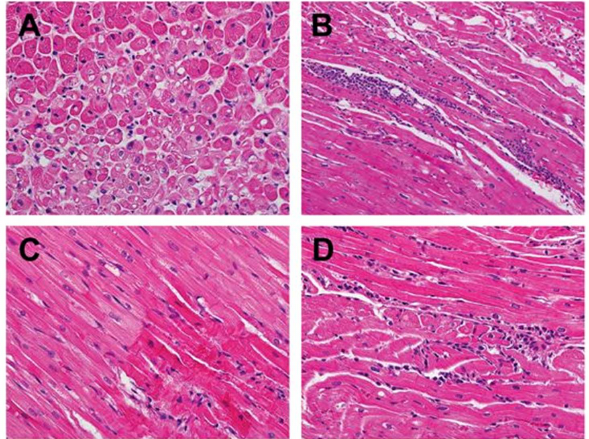
Figure 3. Histopathological changes in the myocardium of animals infected with CVB-H3 (FP41, FP44, and FP46) and CVB3-MCH (FP47). FP41 (A) exhibiting prominent cytoplasmic vacuolization indicative of myocytolysis (400X; H&E stain). FP44 (B) revealing focal, predominantly lymphocytic, mononuclear inflammatory infiltrate with associated myocyte injury consistent with myocarditis (400X; H&E stain). FP46 (C) showing hypereosinophilic, hypercontracted myofibrils indicative of contraction band necrosis of cardiac myocytes (right lower corner) (400X; H&E stain). FP47 (D) demonstrating focal mononuclear inflammatory infiltrate without associated myocardial injury (400X; H&E stain).